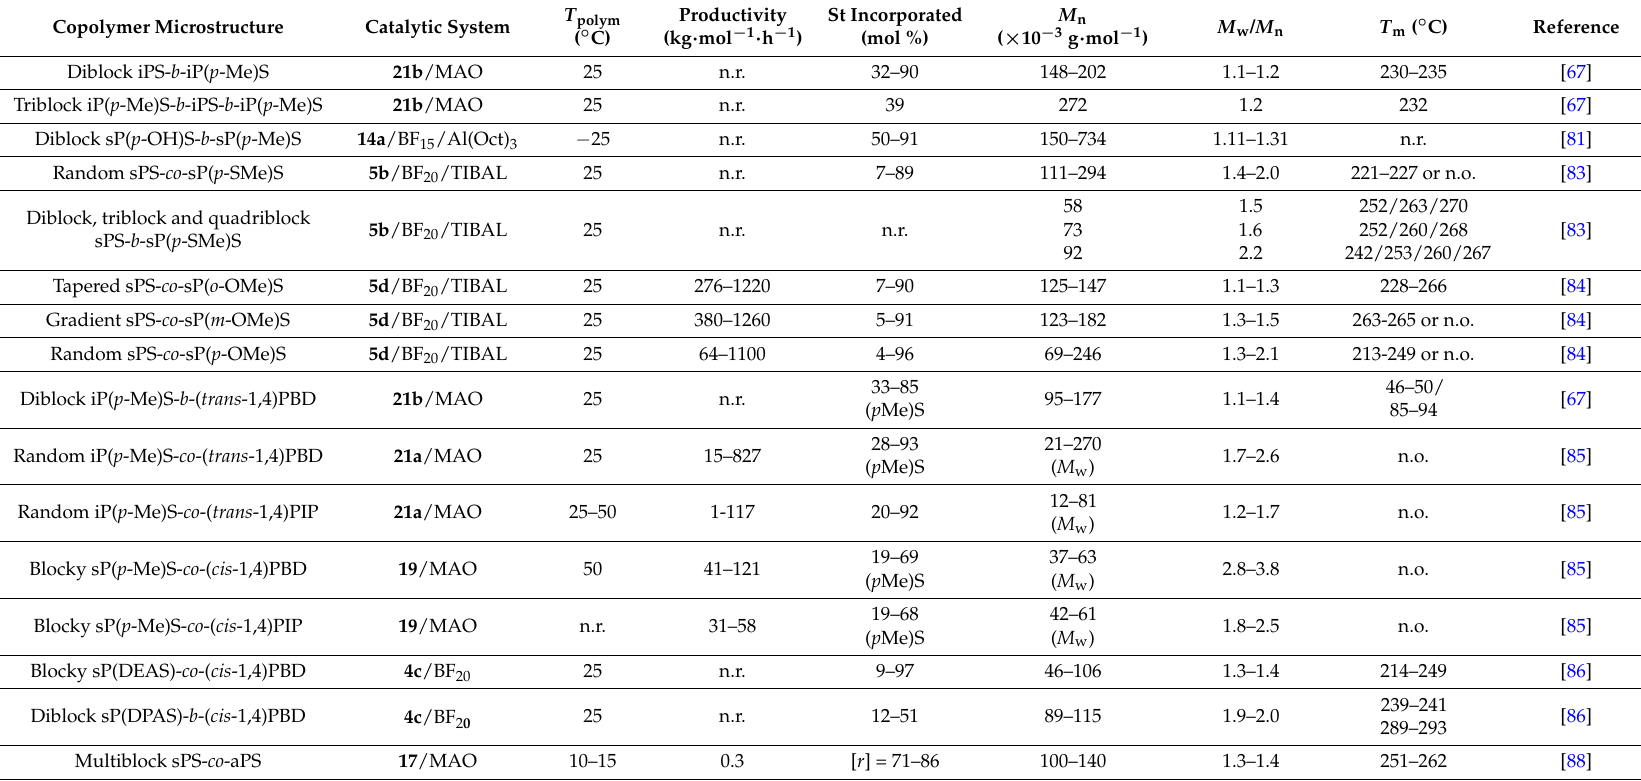
Table 5. Stereoregular styrene derivatives copolymers: catalytic system and polymer